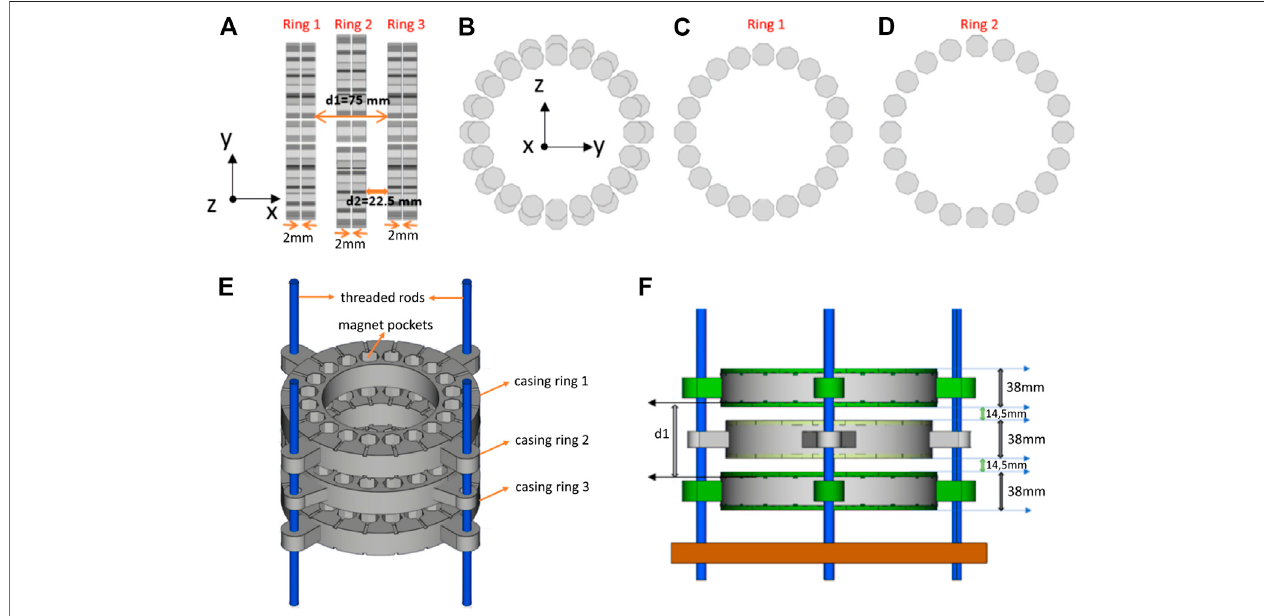
FIGURE 1 | Illustration of the base magnet before shimming. (A) Side and (B) Front view on the base magnet depicting the octagonal magnets of Ring 1 – 3. Front view on (C) Ring 1 (radius r 1 (cid:1) 80.5 mm) and (D) Ring 2 (radius r 2 (cid:1) 89.2 mm). (E) 3D renderings of the magnet casing showing the magnet pockets and threaded rods allowingtoadjustthecorrectdistancebetweentherings. (F) Sideviewofthe3Dmodelofthebasemagnetincludingabaseplatetomountthethreadedrodsandlidsfor each magnet